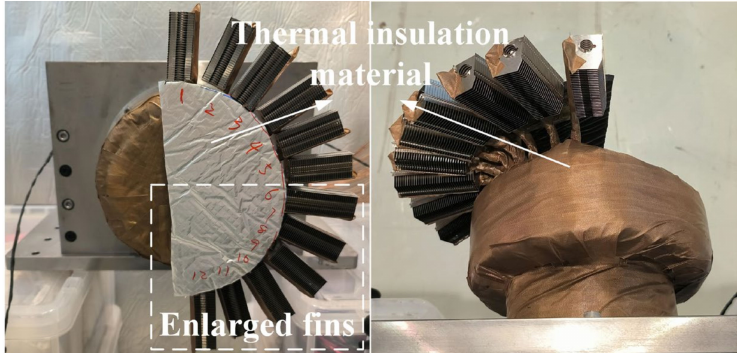
Figure 16. Prepared specimen with expanded fins in the bottom half.